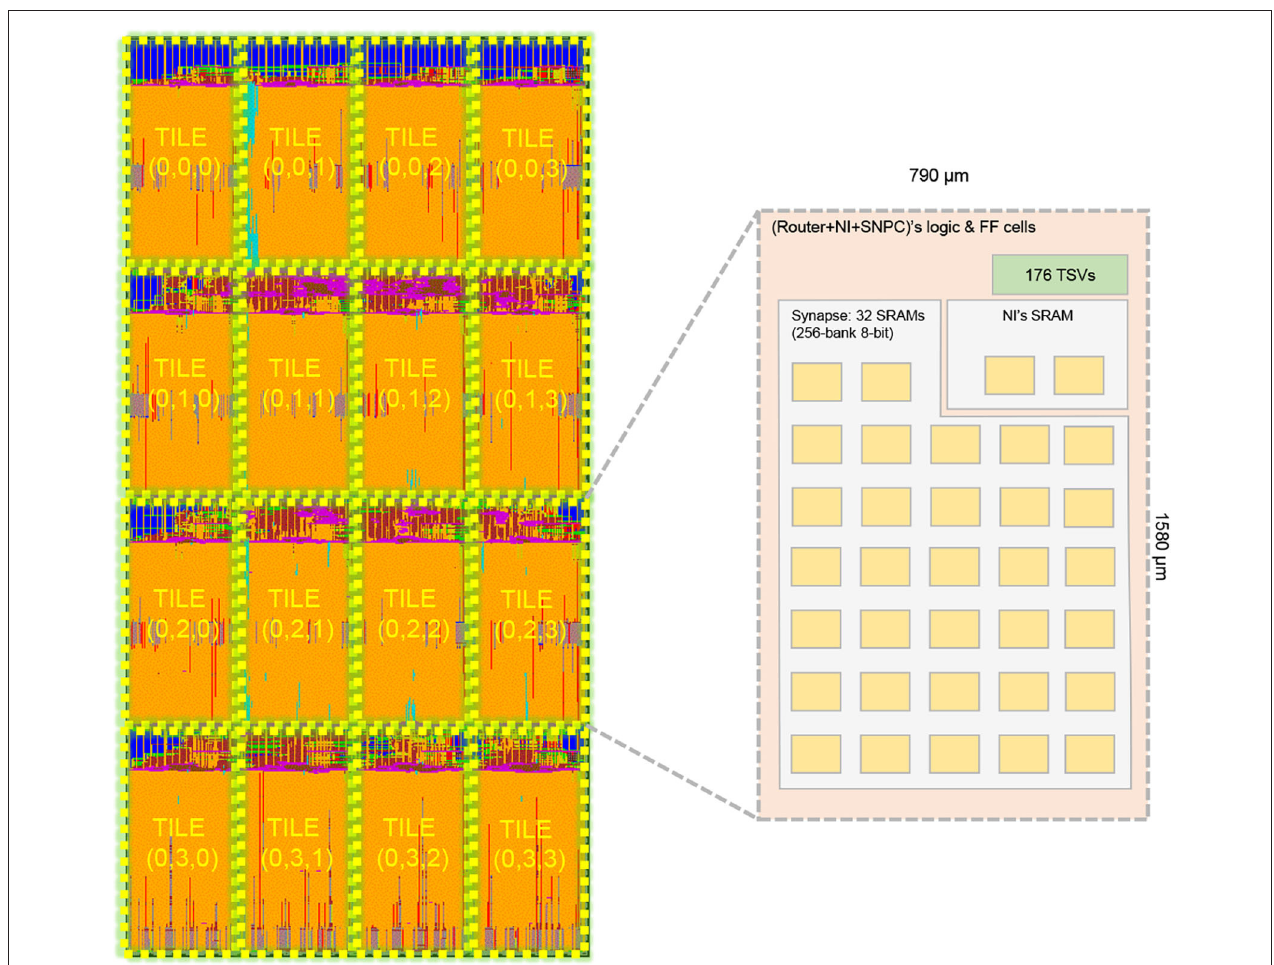
FIGURE 16 | Layout of a 4 × 4 R-NASH layer. A tile’s size is 790 µ m × 1,580 µ m